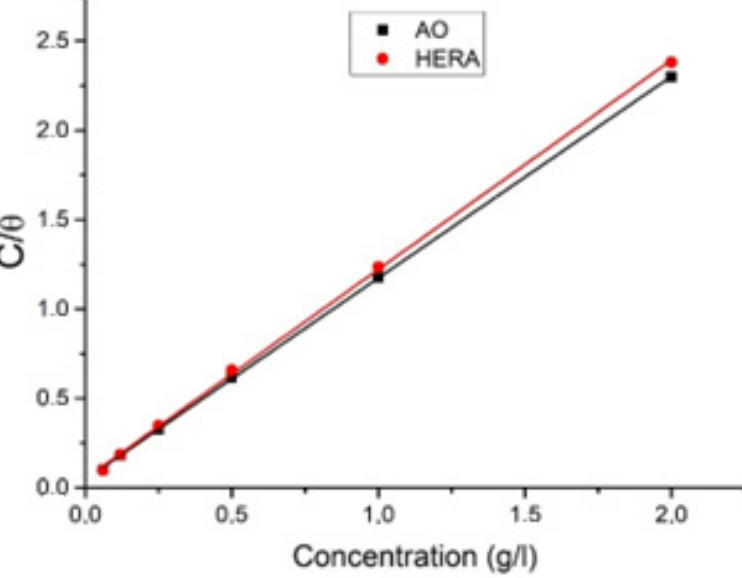
Figure 5. Langmuir adsorption isotherm of mild steel in 1 M HCl in the presence and the absence of AO and